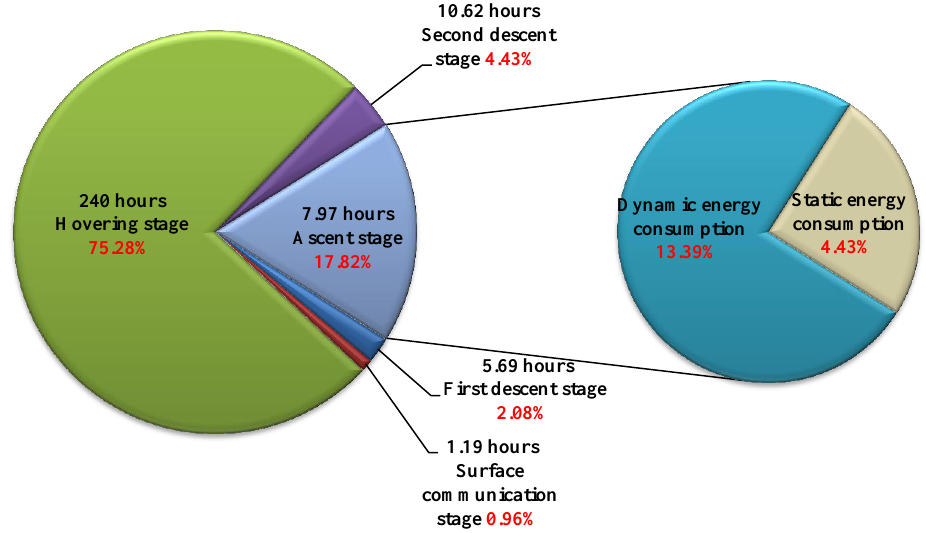
Figure 2. The energy consumption of each working